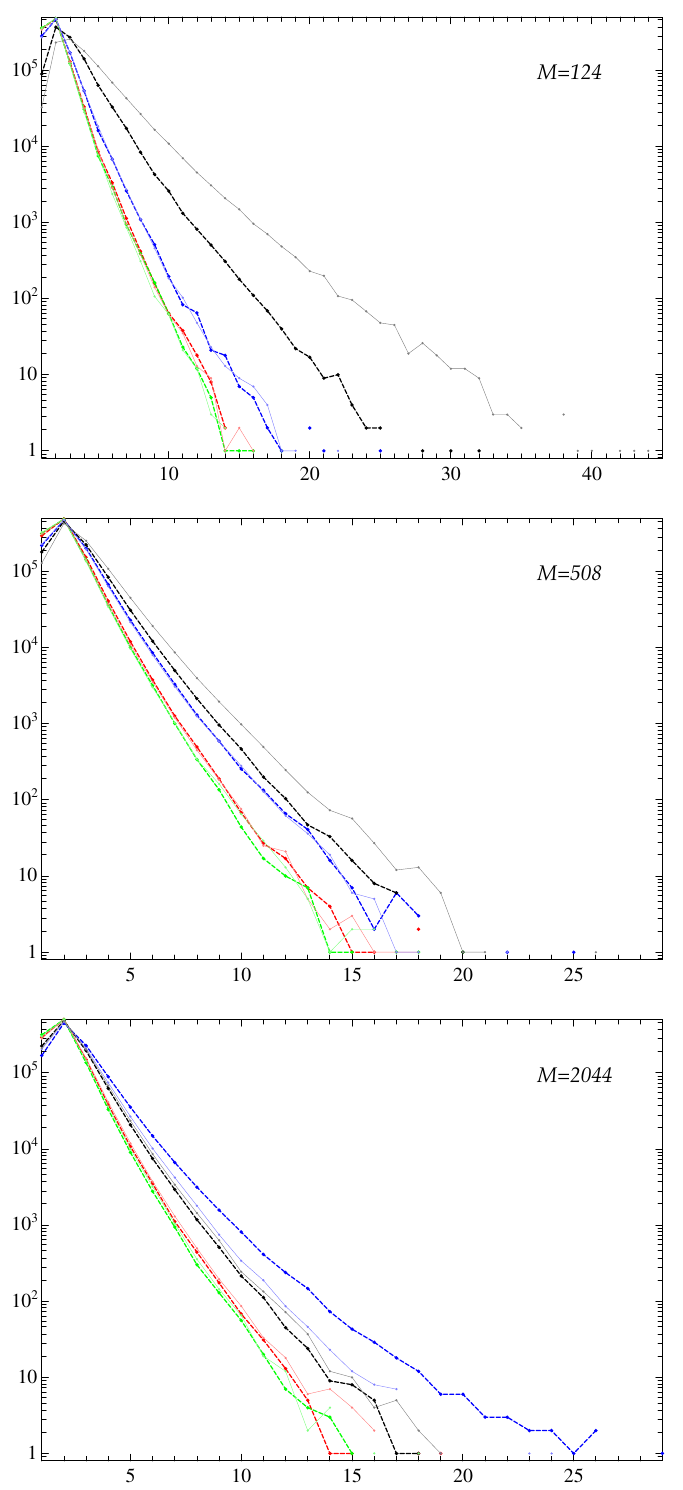
Figure 5. Distribution of error norms of approximate solutions obtained for 10 6 sample test problems by algorithms 1 (red), 1 (cid:48) (green), 2 (blue) and 2 (cid:48) (black colour, respectively) for determining the coefficients of a linear combination of T (cid:63)(cid:63) n ( x 3 ) . Horizontal axis: the error norms relative to the smallest error norm obtained for the test problem by the four algorithms, m ; vertical axis: the number ( k ) of cases, N m , for the k th algorithm and each error norm. Dashed lines, saturated colours: the maximum error norm; thin continuous lines, diluted colours: the energy error norm. The panels show the plots for the three values of the resolution parameter M